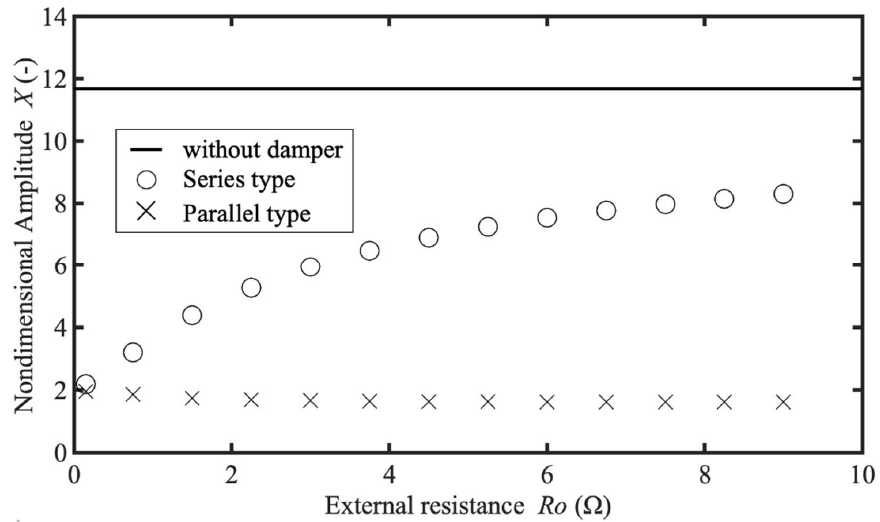
Figure 3. Numerical result of relationship between nondimensional maximum amplitude X and external resistance value (cid:1844) (cid:3016) , obtained with each of the series-type and parallel-type dampers and external resistance value R o , obtained with each of the series-type and parallel-type dampers and without damper. without